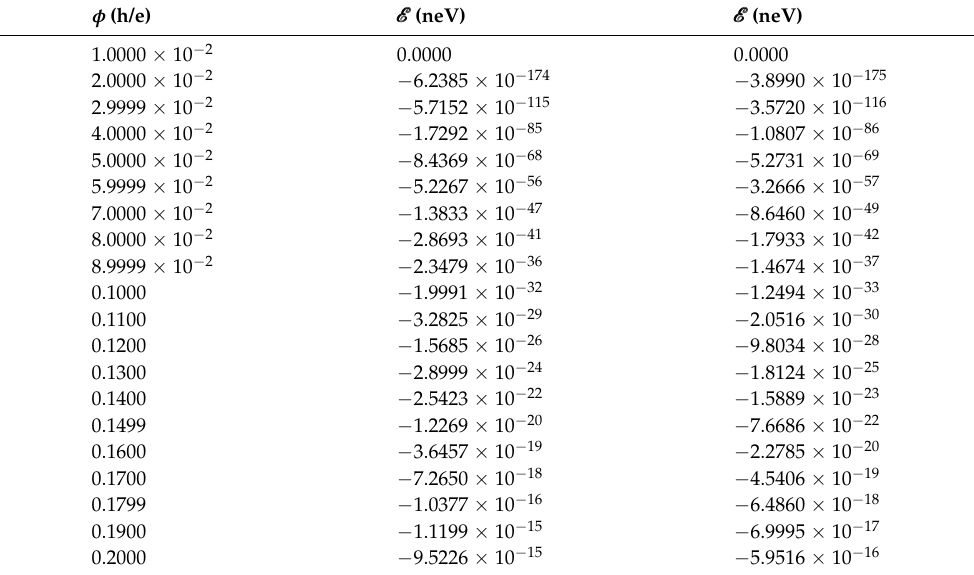
Figure 3. Energy as a function Ω and φ for m = 0 and R = 5 nm. For values of φ larger than 0.5 the energies are negative while for smaller values they are positive. This effect is due to the presence of rotation. Table 1. Some values for the energy E , corresponding to the case displayed in Figure 1d, where we consider Ω = 0. In the second and third columns we show the energies with R = 100nm and R = 400nm,